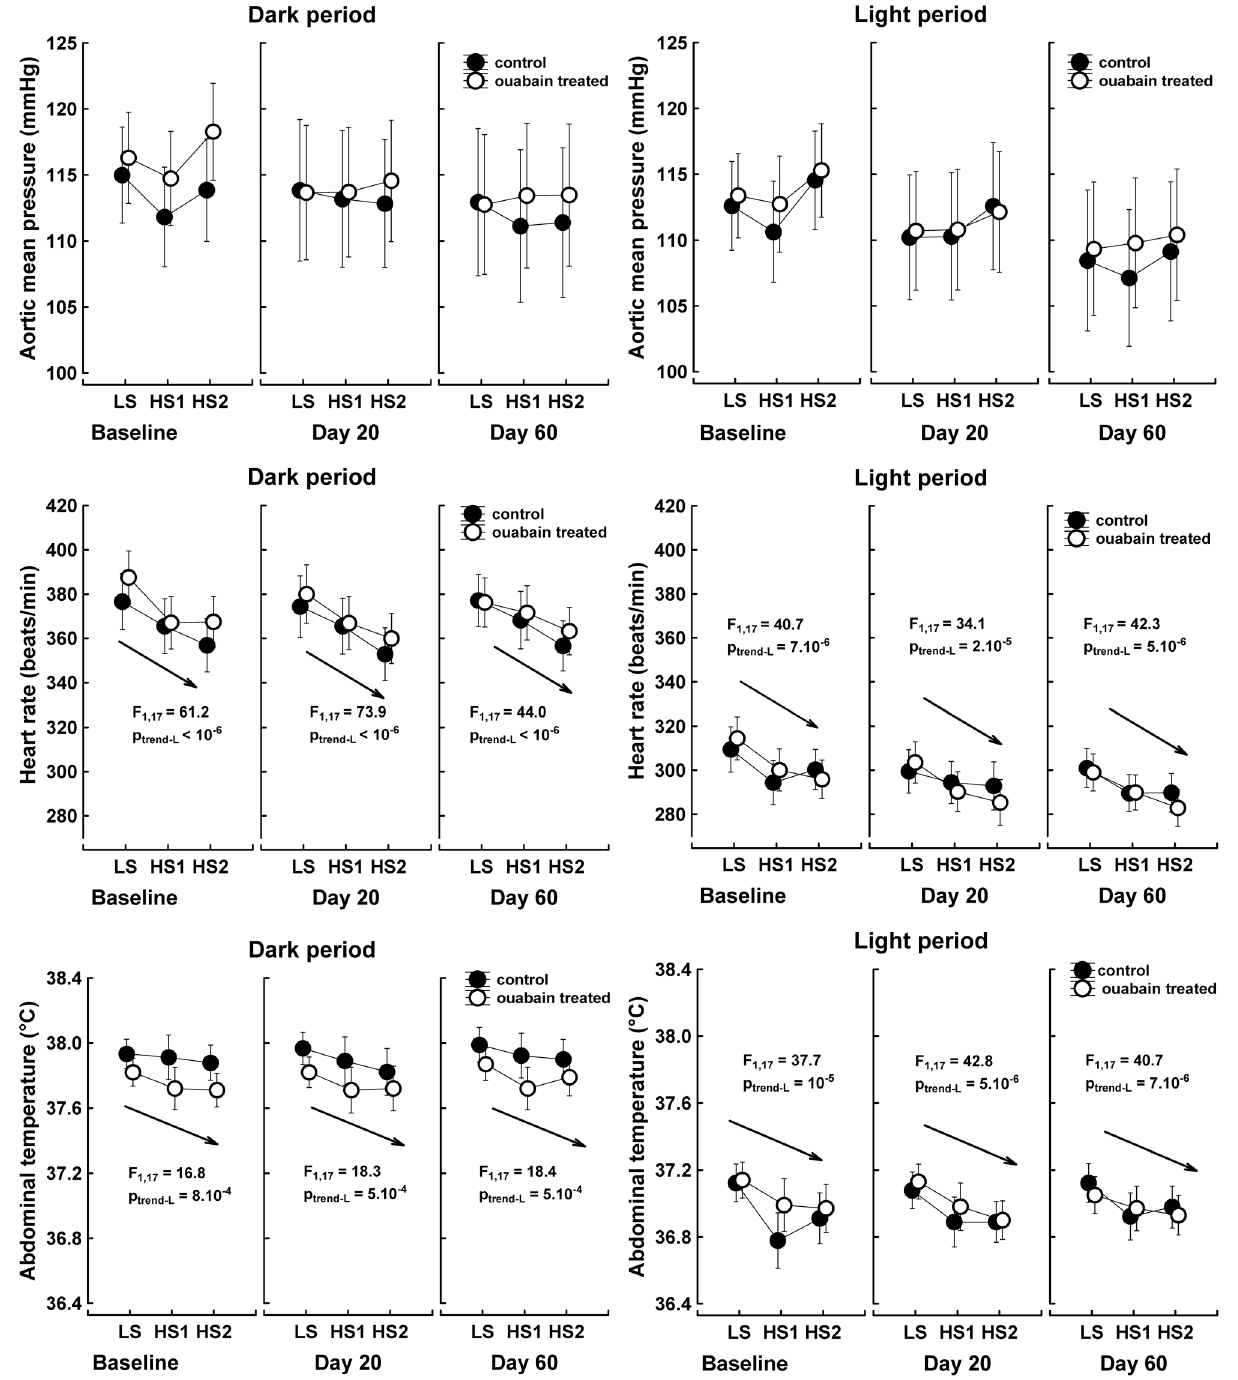
Figure 4. Mean aortic blood pressure, heart rate, and abdominal temperature response to increased NaCl intake. The data points represent the 12-hour means of values measured during the dark and light periods; the vertical bars denote the 95% confidence intervals, n=9 control rats; n=10 ouabain-treated rats. LS, low salt intake; HS1, 1 st day of high salt intake; HS2, 2 nd day of high salt intake. Baseline, salt test performed before the implantation of pellets; Day 20, rats were treated for 27–29 days with 63 m g ouabain/kg/day; Day 60, rats were treated for 40 days with 63 m g ouabain/kg/day and then for 27–29 days with 324 m g ouabain/kg/day. The data were analyzed with repeated measures MANOVA and the multivariate Wilk’s test in a 2 (group) x 3 (time/ouabain treatment) x 3 (salt intake) x 2 (illumination) design. The arrows denote the linear trend analysis that was common for both groups. F, univariate F-test value, subscripts are degrees of freedom. P trend-L , probability that a linear relationship between time and the analyzed parameters is due to chance.